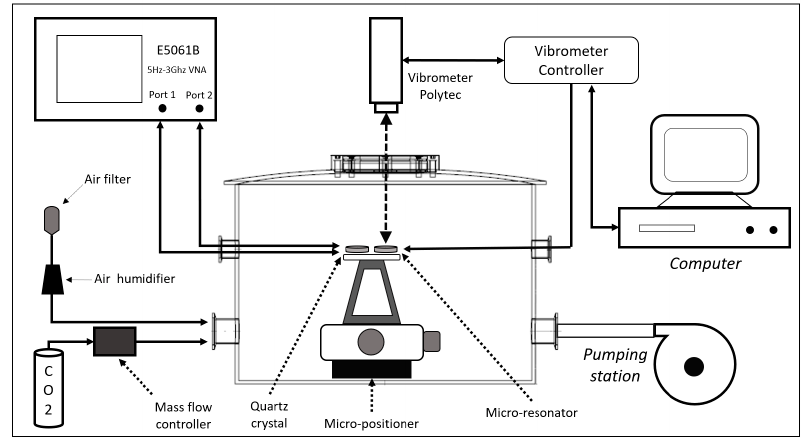
Figure 6. Diagram of the characterization setup.